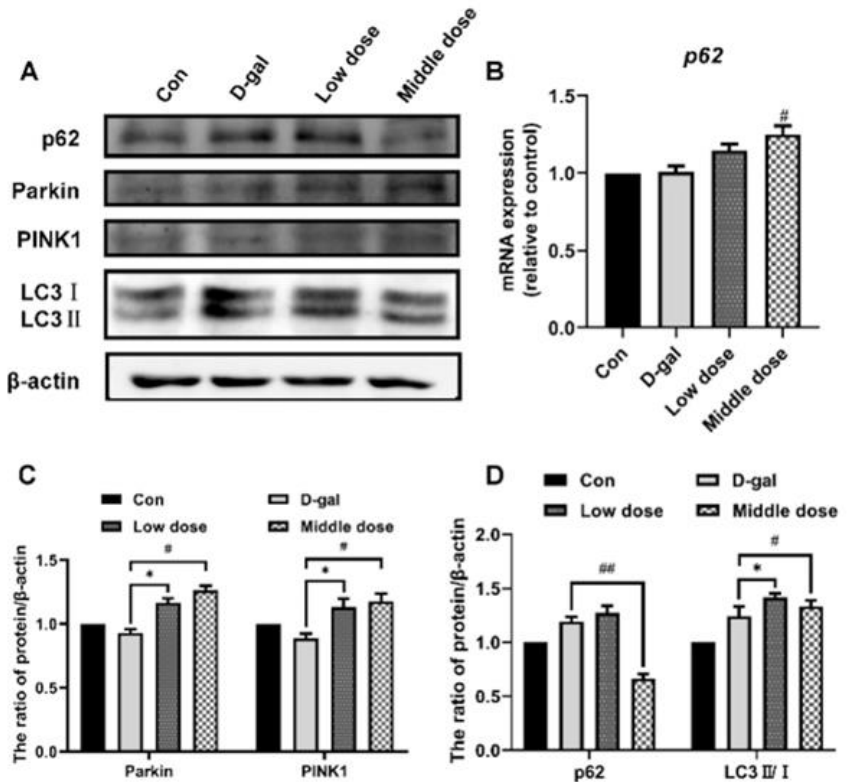
Figure 9. Anthocyanin increased the autophagic flux of mice lenses. ( A ) The expression of p62, LC3II/I, PINK1, and Parkin were measured using western blot. ( B ) The mRNA expression of p62 was measured using RT-qPCR. ( C , D ). The quantification of expression of p62, LC3II/I, PINK1, and Parkin. Data are presented as mean ± SD, n = 3. * p < 0.05, # p < 0.05, ## p < 0.01.